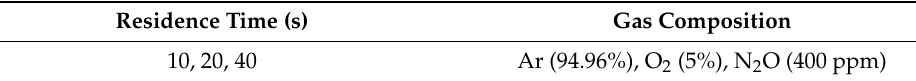
Table 1. Test gas condition [27].